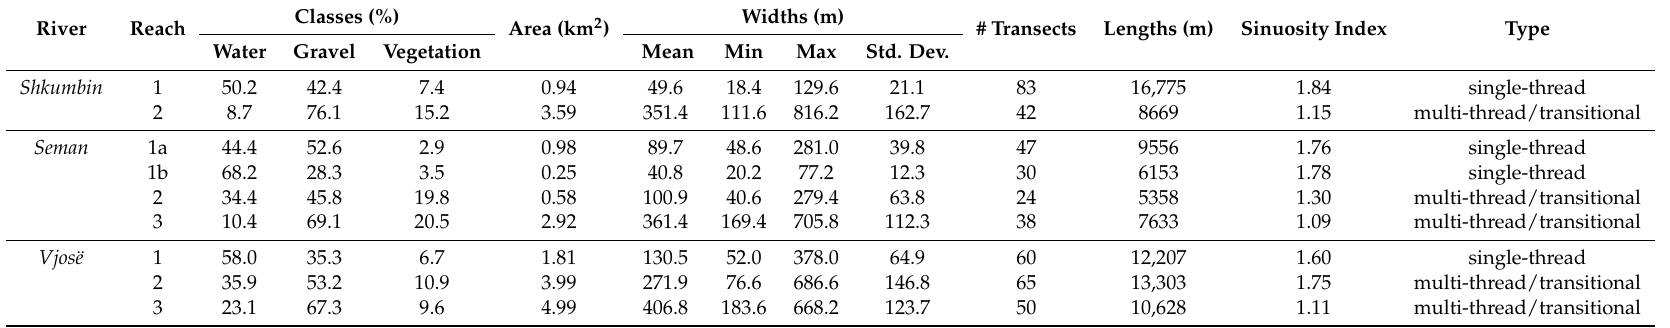
Table 6. Coverage classes distribution, active channel widths and standard deviations, active channel areas, number of transects, channel centerline lengths, sinuosity indices and fluvial reaches classification obtained from the processing of the 2007 aerial